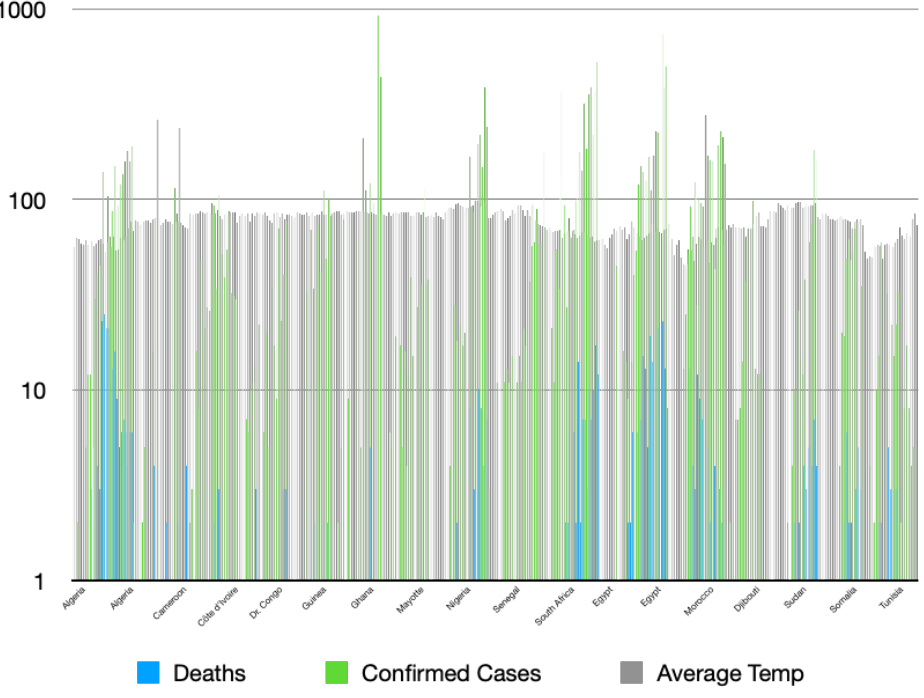
Fig. 14. Drivers of COVID-19 mortality in